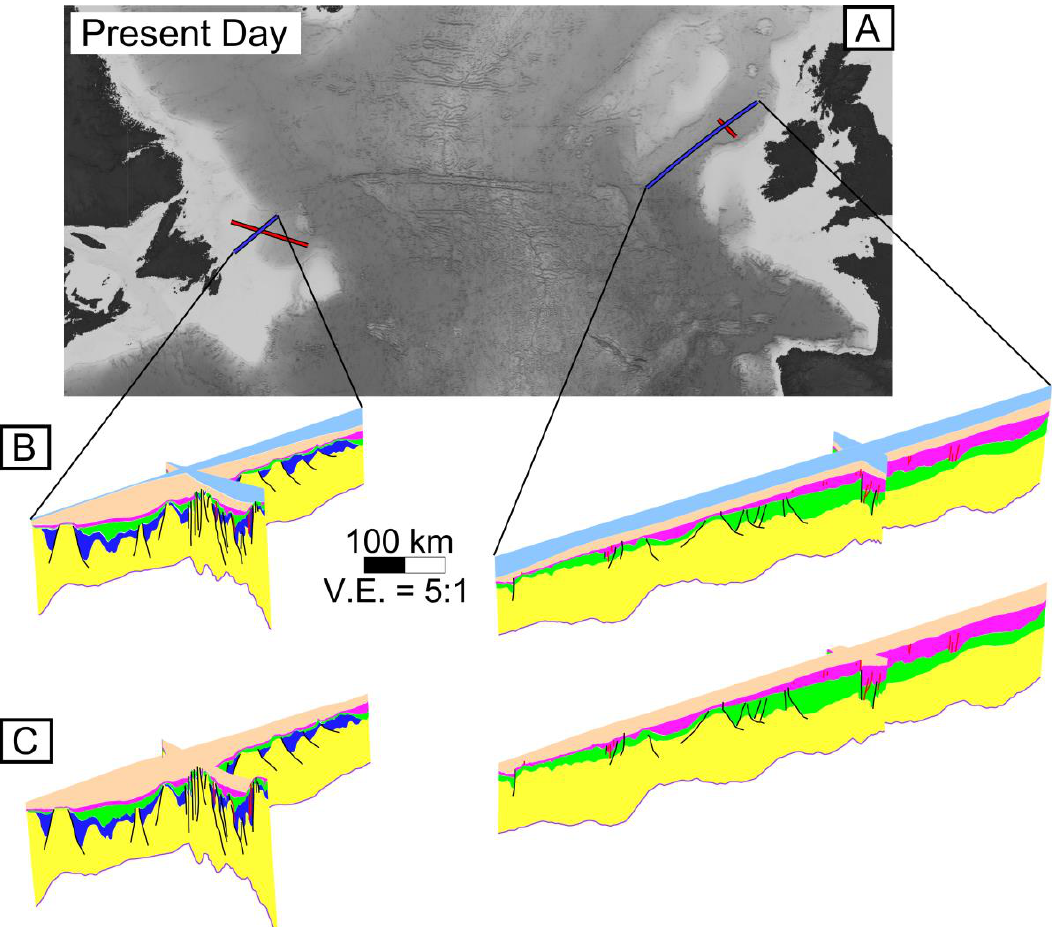
Figure 7. ( A ) Model in GPlates of the Newfoundland-Ireland conjugate margins, present day, with background image showing bathymetry. ( B ) 3D model of seismic lines NL1 and NL2 (left) in the Orphan Basin and 3D model of seismic lines IR1 and IR2 (right) in the Rockall Basin, present day. ( C ) 3D model of seismic lines NL1 and NL2 (left) in the Orphan Basin and 3D model of seismic lines IR1 and IR2 (right) in the Rockall Basin with the Cenozoic sedimentary sequence decompacted. Black lines represent primary faults and red lines represent secondary faults. For meaning of layer colours, see legend in Figure 6.